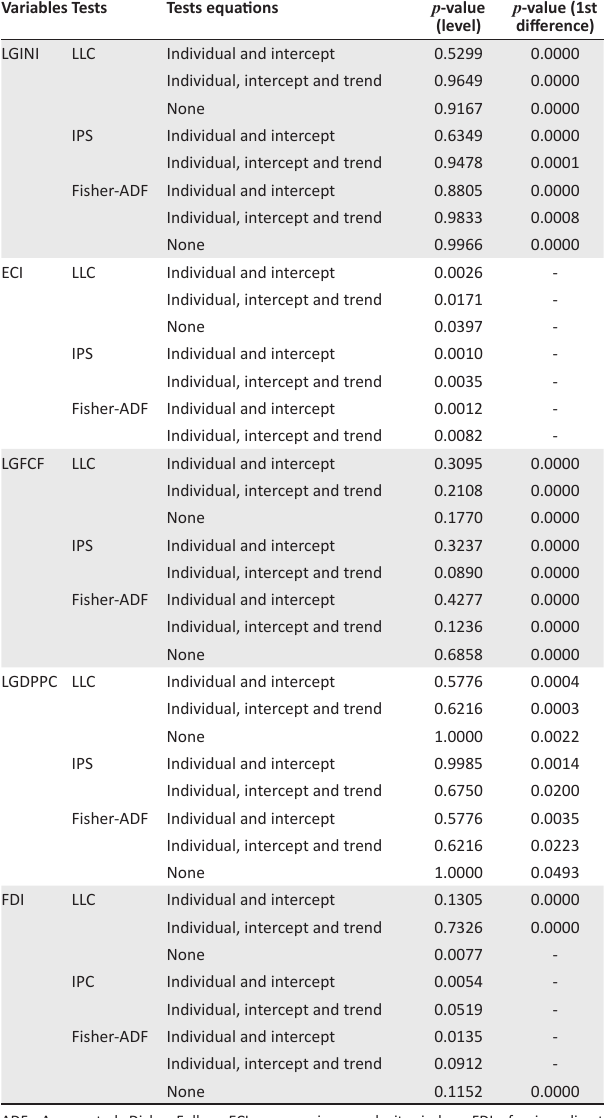
TABLE 1-A1: Summary of panel unit root test.